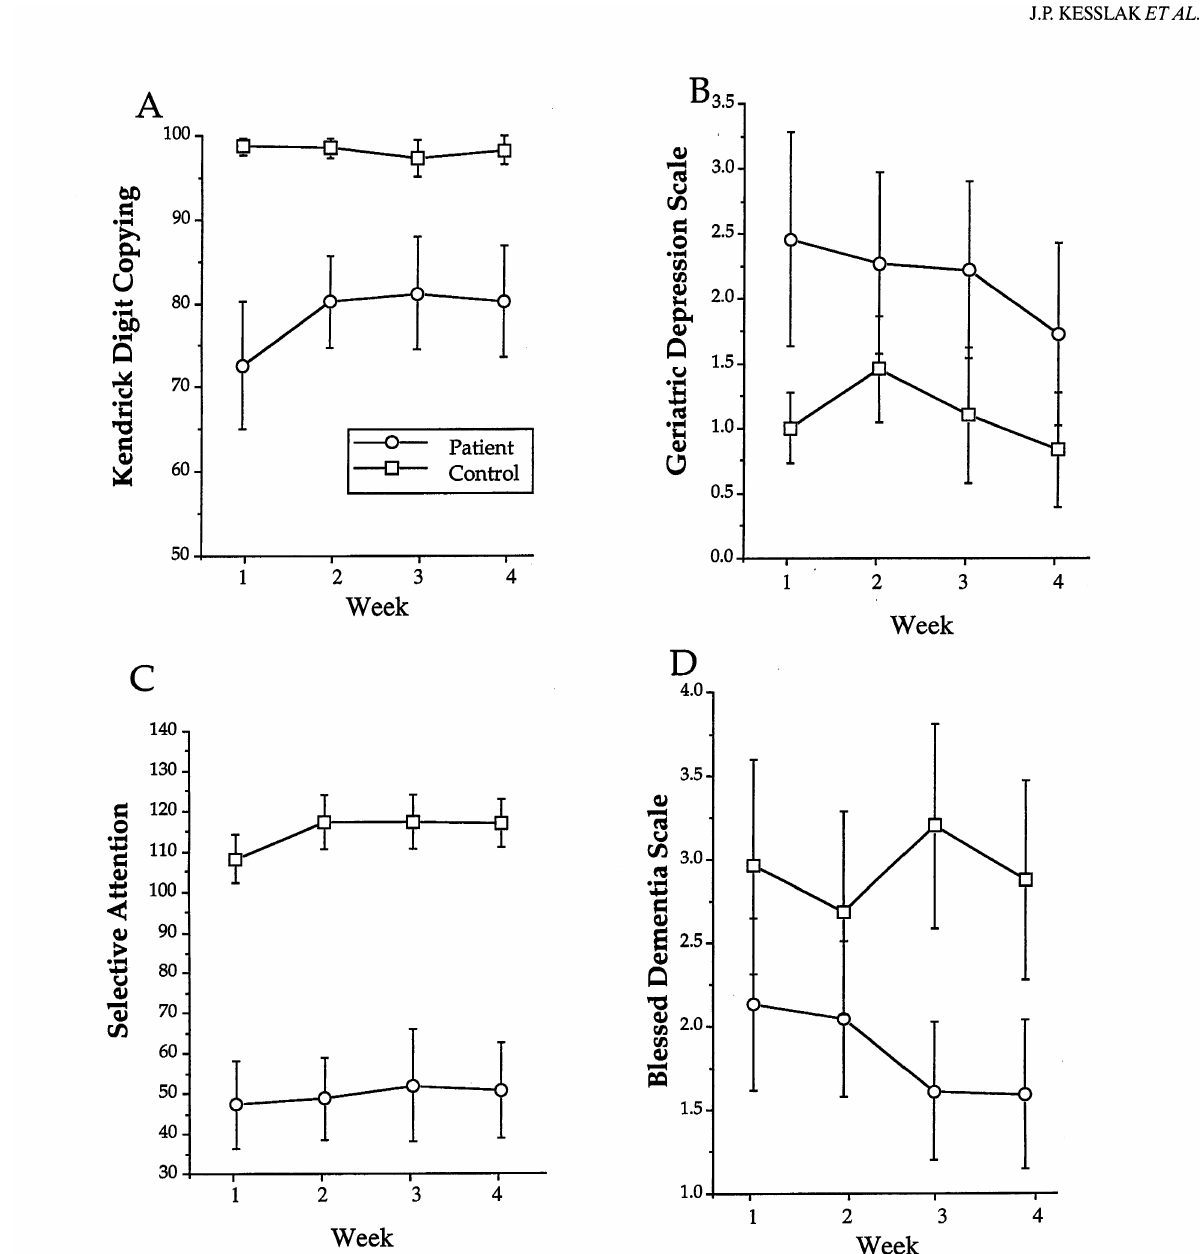
FIG. 2. (A) Patients showed the most dramatic increase on the Kendrick Digit Copying task between weeks 1 and 2 of the memory training. Control performance was stable at a significantly higher level of performance compared with patients. (B) Scores on the Geriatric Depression scale indicated that overall patients rated themselves more depressed than controls, which decreased slightly during the memory training. (C) Both patients and controls showed stable per formance on the Selective Attention task across training sessions, with controls having consistently more correct responses than patients. (D) Ratings of activities of daily living from the Blessed Dementia Scale indicated that when patients were given a task that improved performance, caregiver ratings indicated an increase in functional deficits, whereas patients rated themselves as